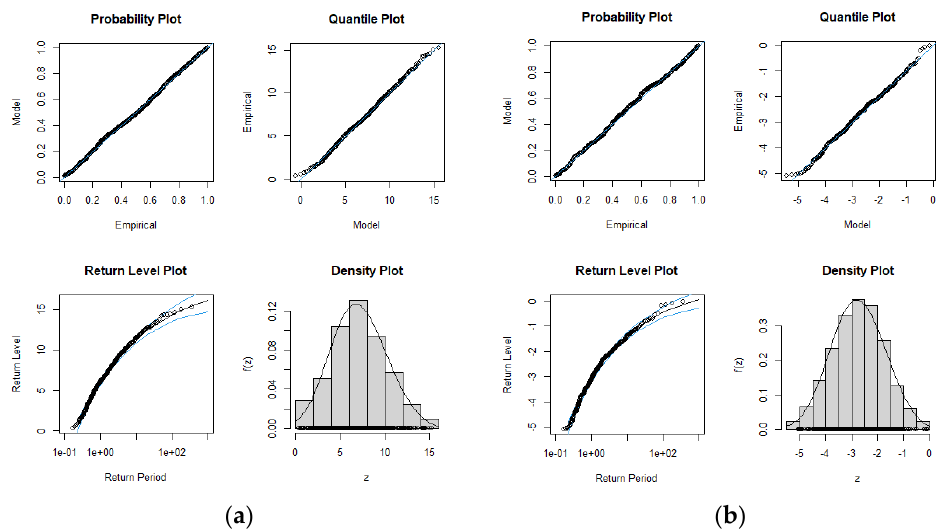
Table 2. Sample data parameter estimation and extreme distribution types of steel box girder.